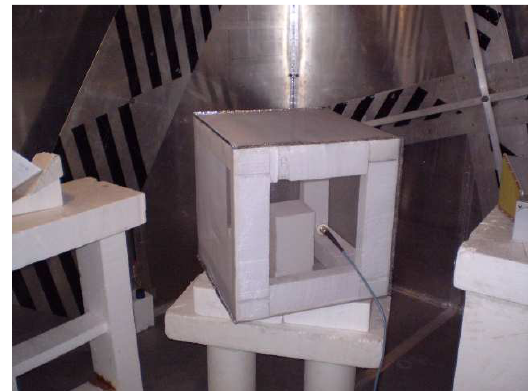
Figure 4: SE e from measurements of 5 mm mesh size enclosure.